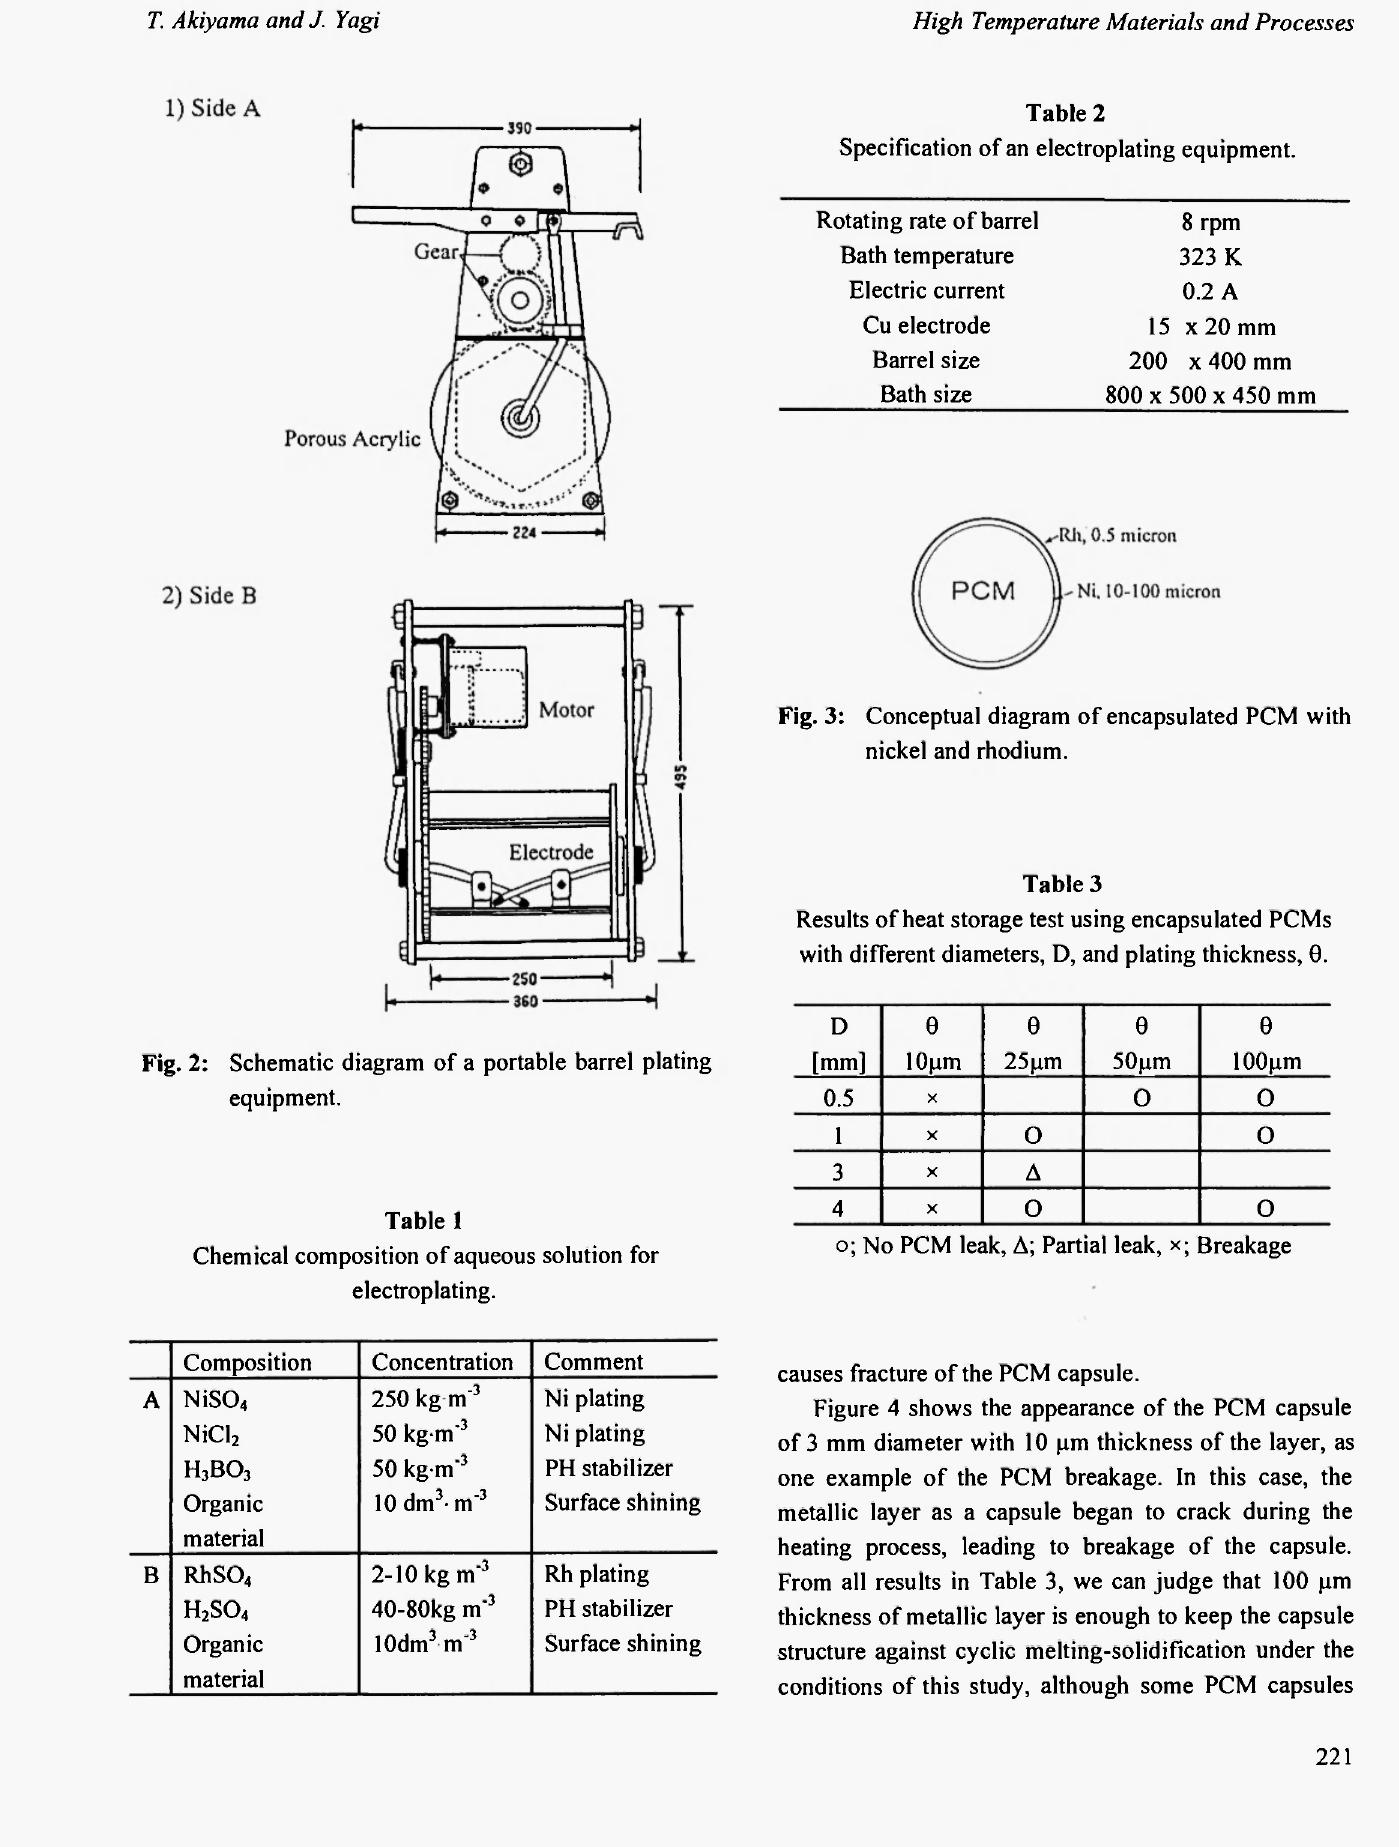
Specification of an electroplating equipment.